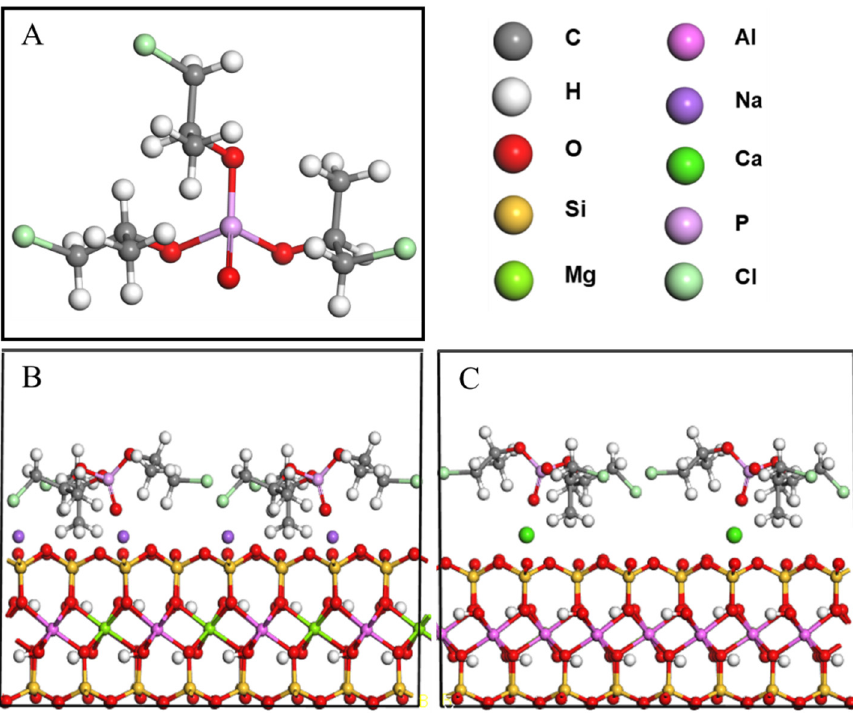
Figure 1. Molecular models of TCPP ( A ), TCPP/NaMMT ( B ), and TCPP/CaMMT ( C ).